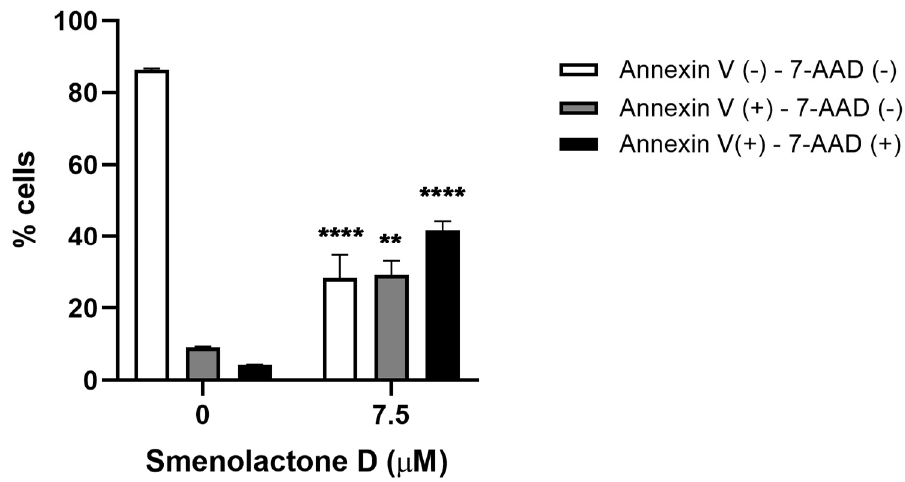
Figure 5. Smenolactone D induces PCD in Jurkat cells. Percentage (%) of viable cells (annexin-V − /7- AAD − ), in the early stages of PCD (annexin-V + /7-AAD − ) or necrotic/in the late stages of PCD (annexin-V + /7-AAD + ) following 48 h treatment with smenolactone D (7.5 μ M). ** p < 0.01; **** p < 0.0001 compared to untreated cells.